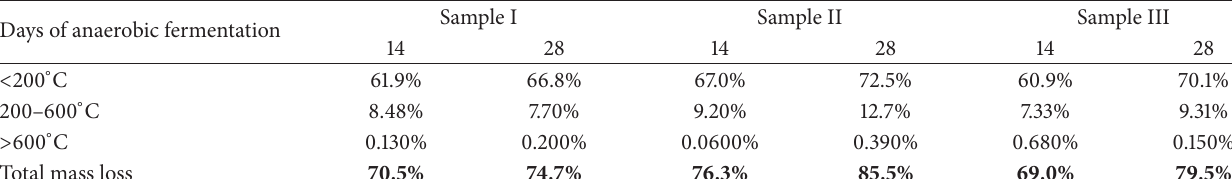
Table 3: The percentage of quality loss.